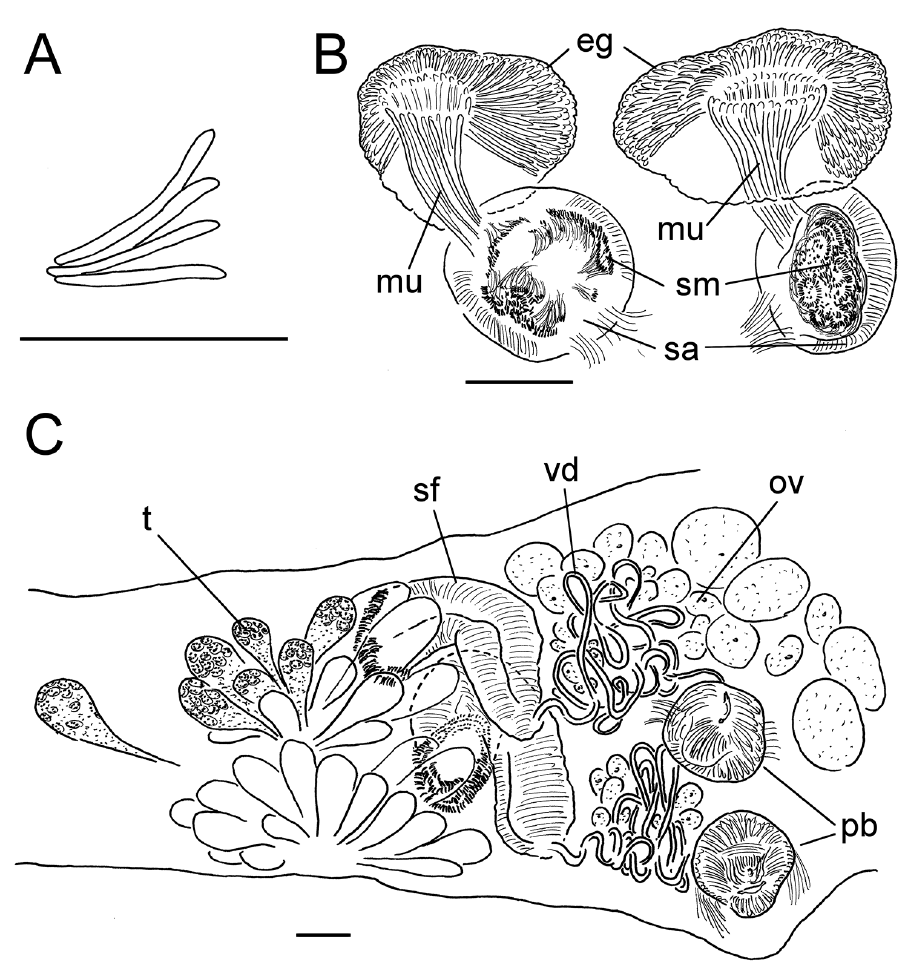
Figure 18. Lumbricillus helgolandicus . A Chaetal bundle B Spermathecae C Other genitalia. Abbrevia- tions under general notes. Scale bars: 100